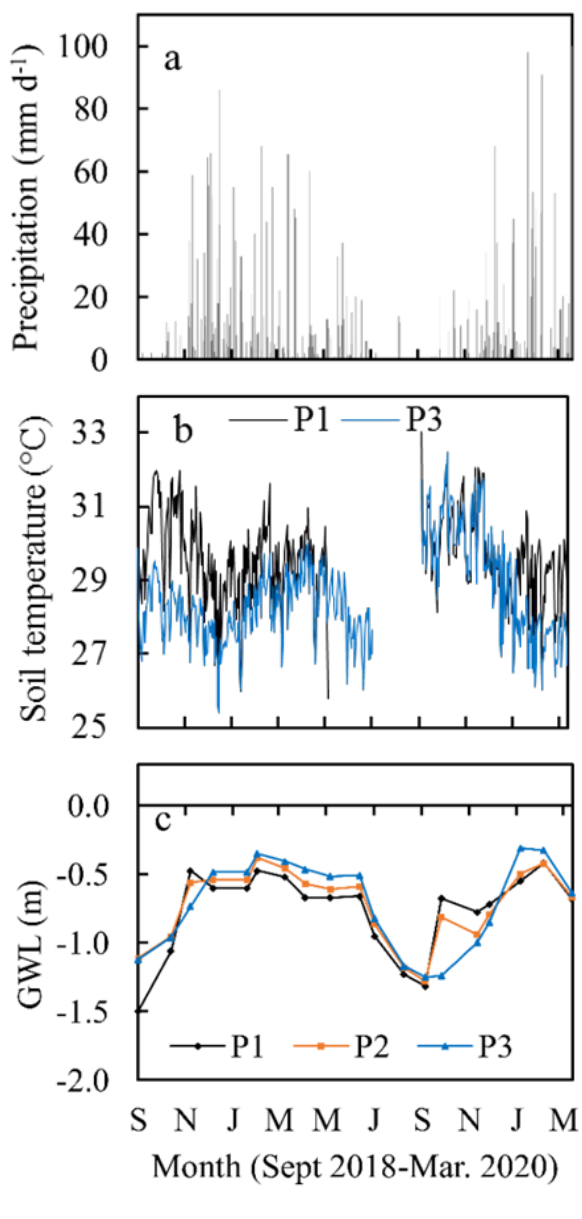
Figure 2. Variations in daily values (September 2018 to March 2020) of (a) precipitation and (b) soil temperature in Plots 1 and 3, and (c) groundwater level (GWL) from monthly manual measurements in Plots 1, 2 and 3.